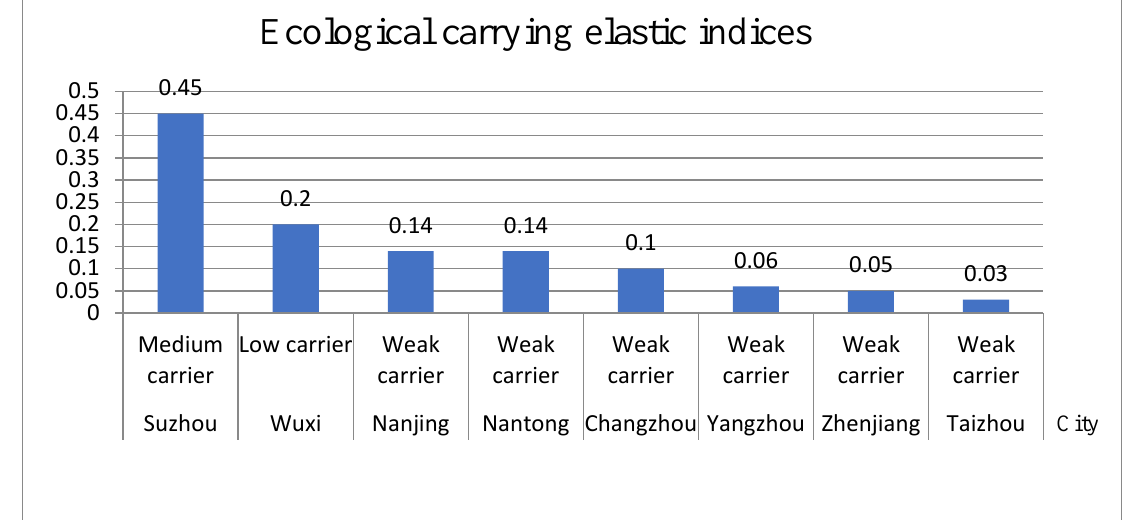
Figure 2. Histogram of ecological carrying elastic indices for the Yangtze River urban agglomeration.